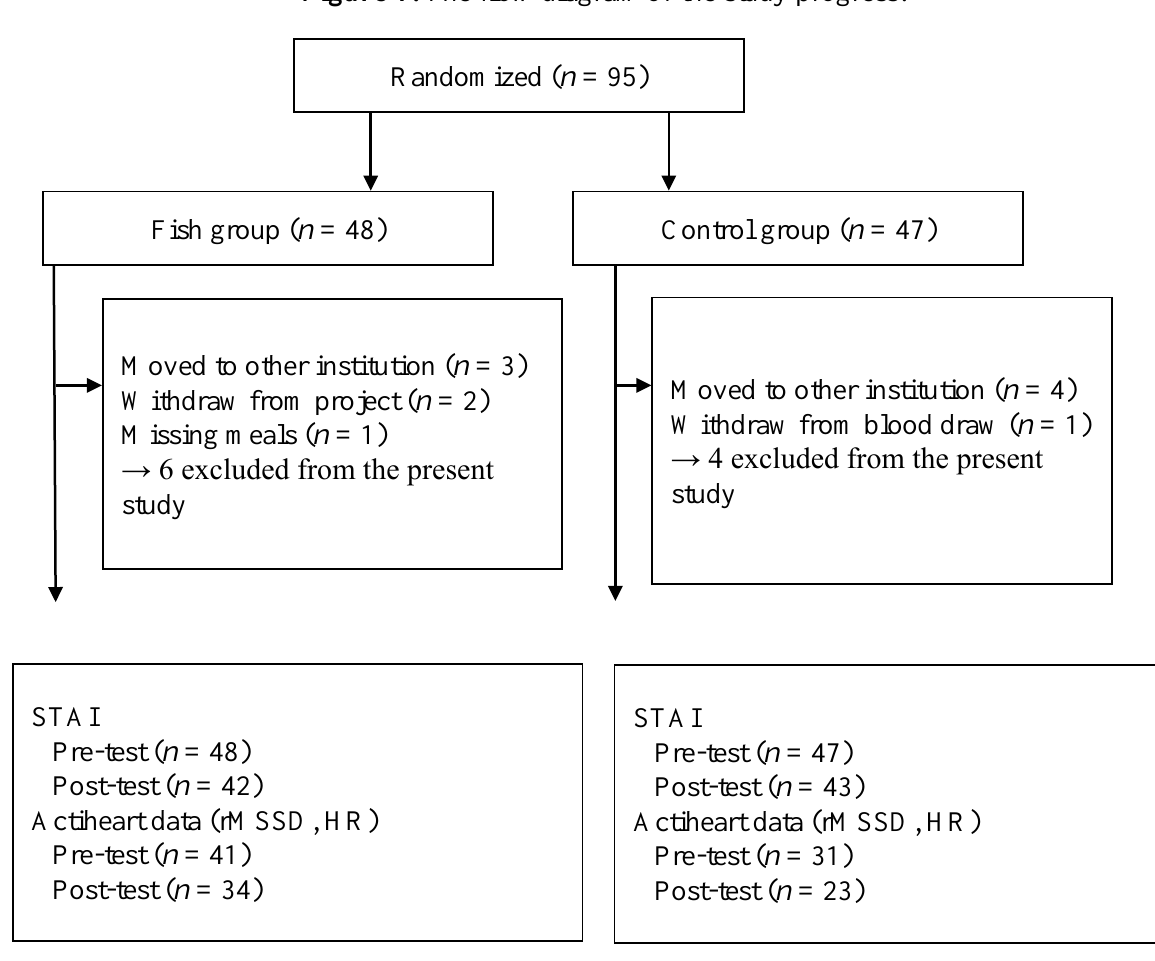
Figure 1. The flow diagram of the study